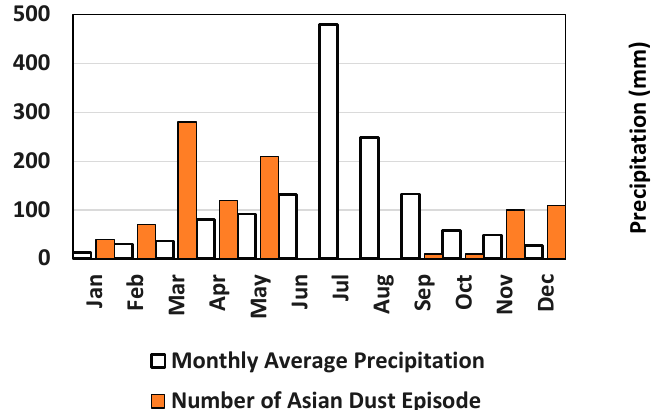
Figure 4. The number of episodes of Asian dust and monthly precipitation between 2008 and 2018 [21].